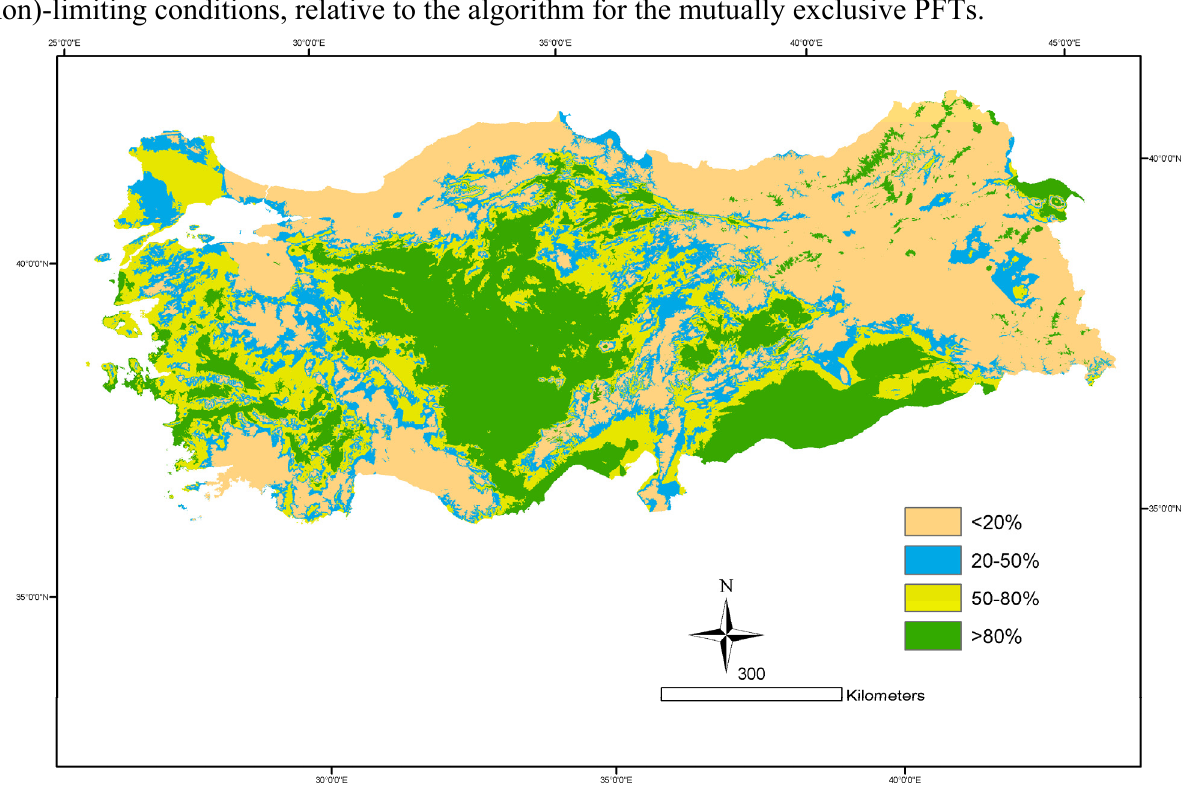
Figure 6. Spatial distribution of fractional shrub cover.